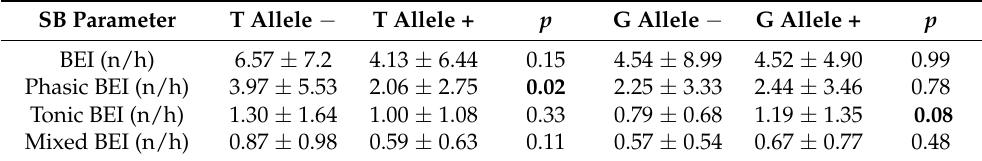
BEI, bruxism episode index; values are shown as mean ± SD; statistically significant differences ( p < 0.05) marked as bold. Because of the significant difference between phasic BEI (2.06 vs. 3.97) in patients for the presence of T allele in the locus of the TERT gene, the receiver operating characteristic (ROC) curve was generated. Based on the ROC curve, the value of PhE/h = 0.8 was determined as the differentiating value for the prediction of the presence of T allele in the studied locus (Figure 1).